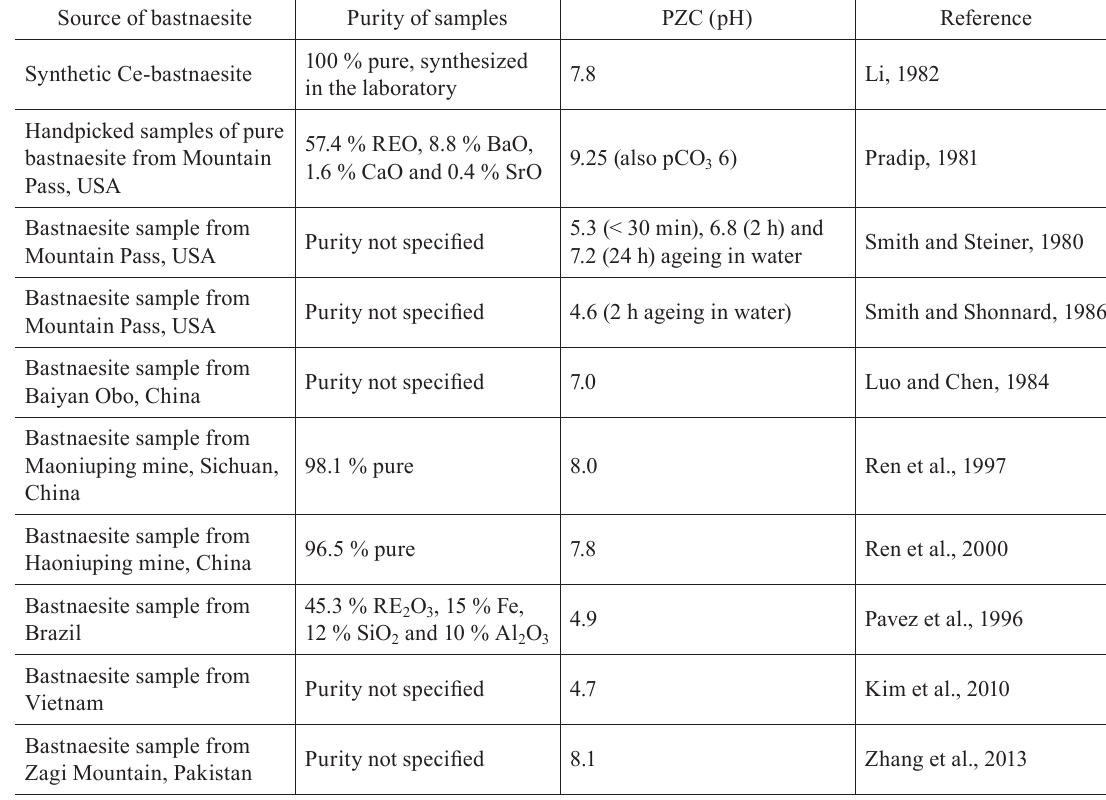
Table 1 Point of Zero Charge (PZC) values for bastnaesite as reported in the literature Source of